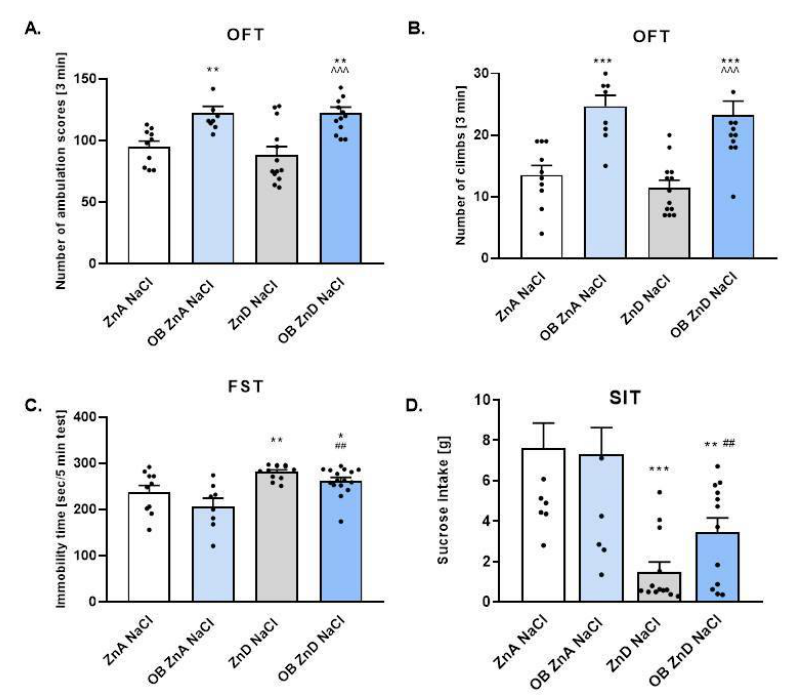
Figure 1. The effect of OB, ZnD, and OB + ZnD models on the behavior of rats in the open field test (OFT, ( A , B )), forced swim test (FST, ( C )), and sucrose intake test (SIT, ( D )). Data were analyzed using a two-way ANOVA and the Newman–Keuls multiple comparisons test, * p < 0.05, ** p < 0.01, *** p < 0.001 vs. ZnA NaCl; ˆˆˆ p < 0.001 vs. ZnD NaCl; ## p < 0.01 vs. OB ZnA NaCl. Values are expressed as mean ± SEM ( n = 8–15). OB: olfactory bulbectomy model, ZnD: zinc-deficient diet, and OB + ZnD: olfactory bulbectomy model and zinc-deficient diet.